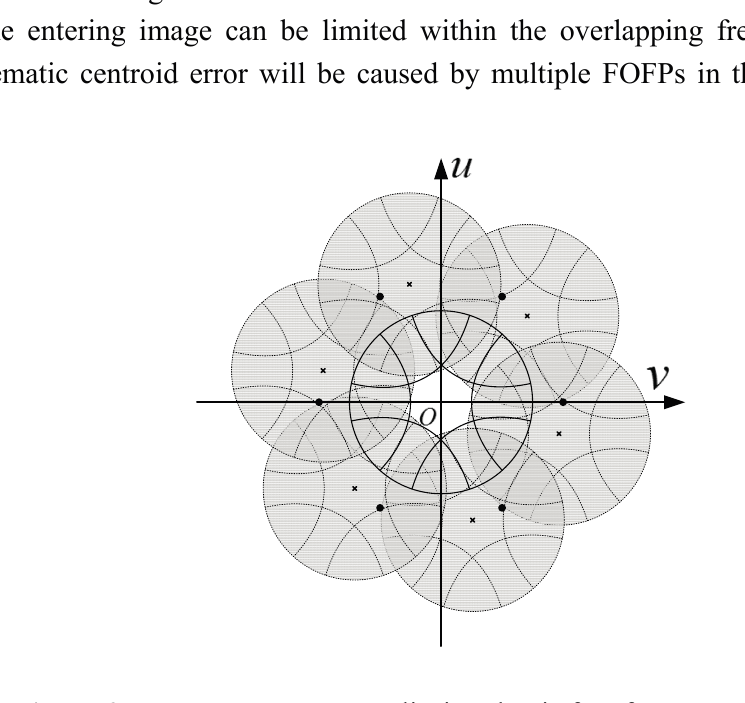
Figure 9. Frequency spectrum aliasing that is free from centroid